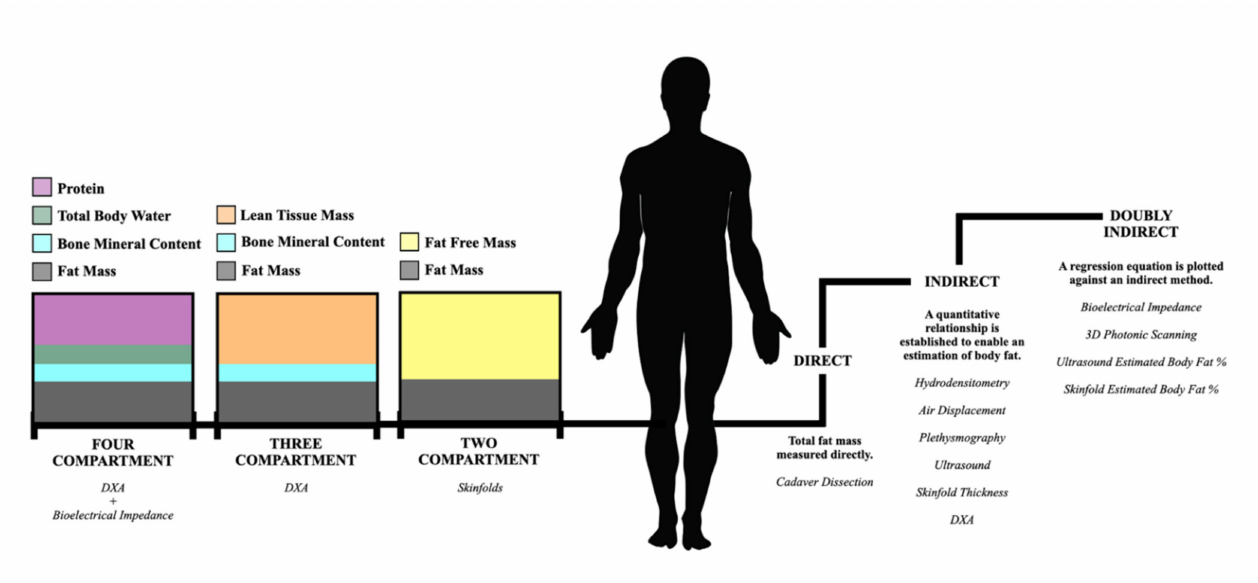
Figure 1. The 2-, 3- and 4-compartmental models of human body composition (left hand side), alongside the validation hierarchy (right hand